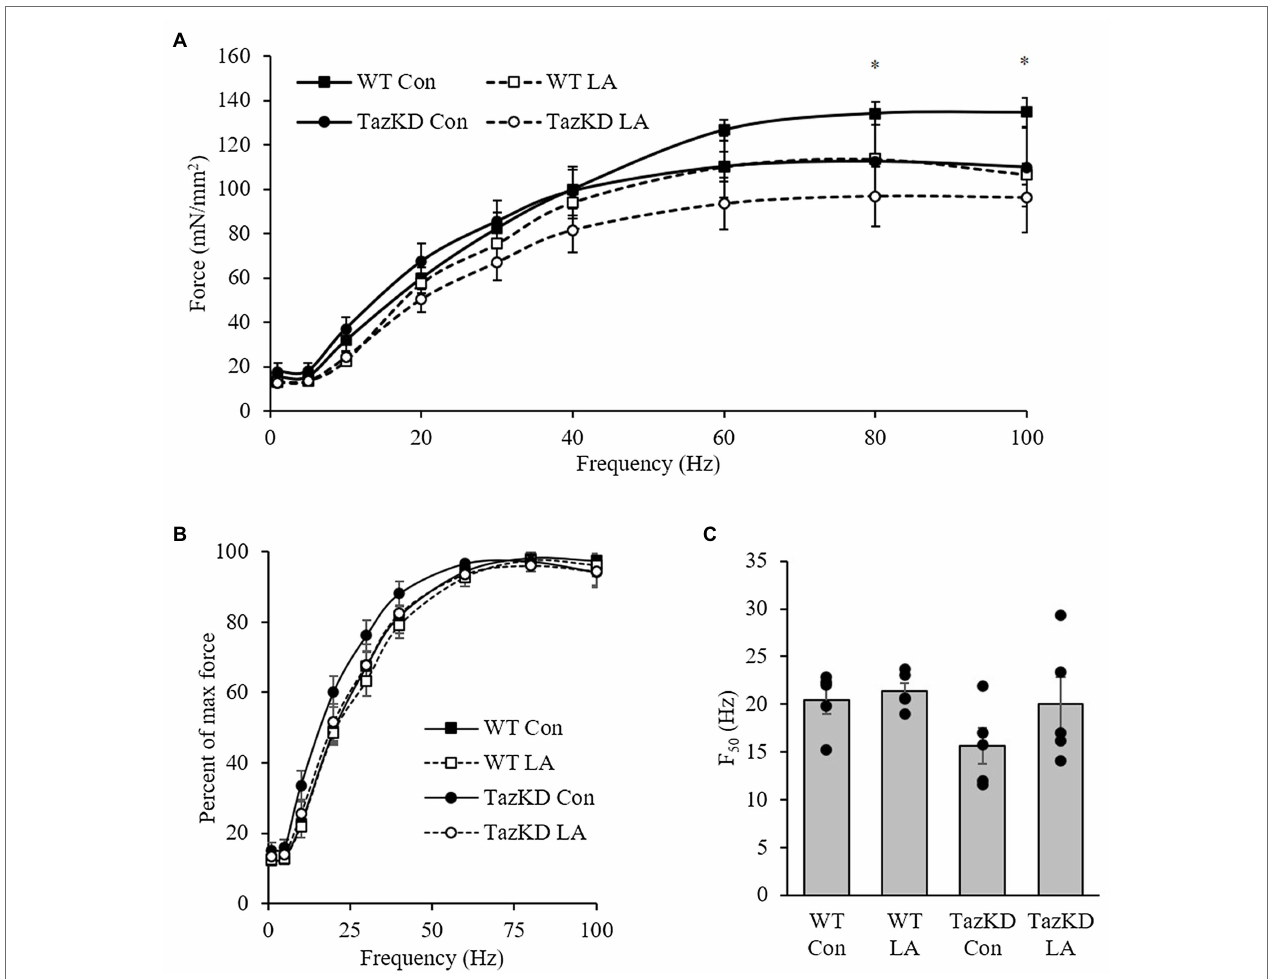
FIGURE 5 | TazKD compared to wild-type male mice fed control diet show altered twitch kinetics as demonstrated by (A) the representative trace. (B) Time to peak twitch force was slower in TazKD soleus compared to WT and was attenuated by the LA diet. In comparison, (C) half-relaxation time was also slower in TazKD soleus compared to WT and was somewhat attenuated with the LA diet. Values are means ± SEM, n = 5; no statistical difference between values with the same letter ( p < 0.05). WT, wild type; TazKD, Taz knockdown; Con, chow diet; and LA, linoleic acid-supplemented